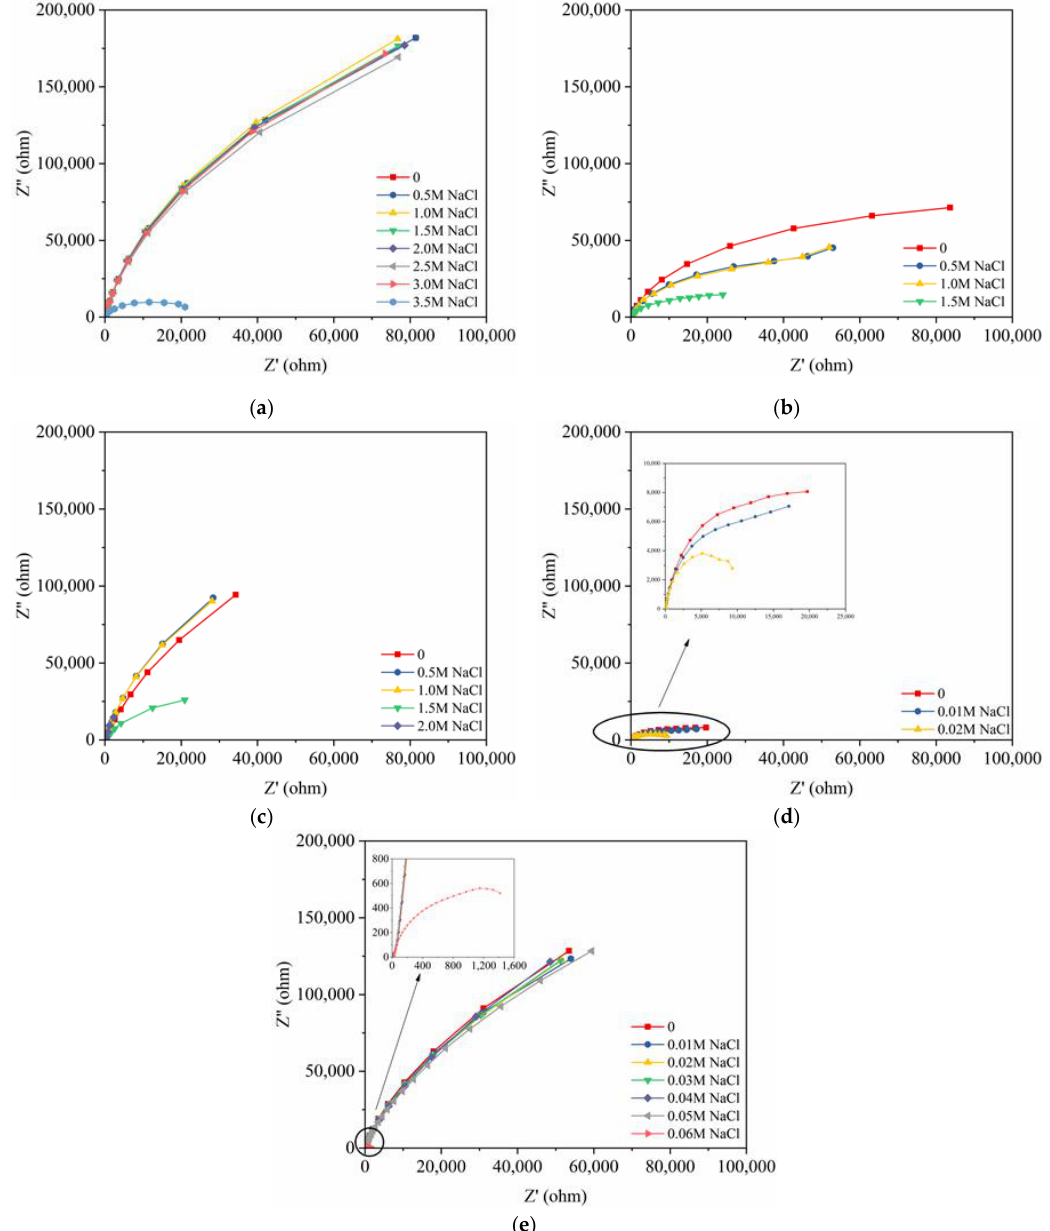
Figure 5. Nyquist curves of the steels based on the EIS measurements: ( a ) novel type-2205 duplex stainless steel; ( b ) type-2205 duplex stainless steel ( c ) type-316 austenitic stainless steel; ( d ) HRB400; ( e ) HRB500.